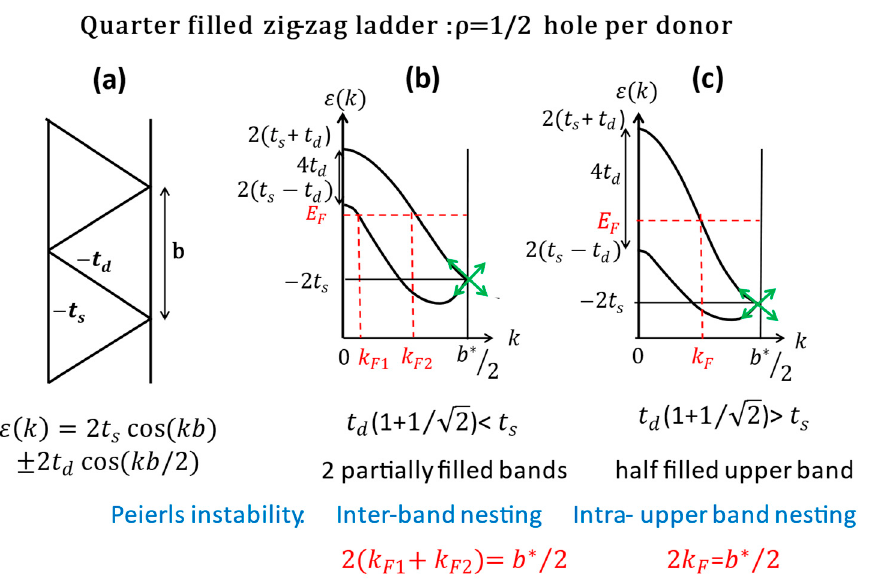
Figure 10. Band structure of the quarter fill zig-zag ladder shown in ( a ). With one-half hole per donor and for decreasing ratio of transfer integrals t s /t d one shifts from a two partially filled band structure ( b ) to a half-filled upper band structure ( c ). The Peierls instability is achieved by an inter-band nesting process in ( b ) and by an intra-upper band nesting process in ( c ). For half a hole per donor, both FS nesting processes always occur at b*/2.